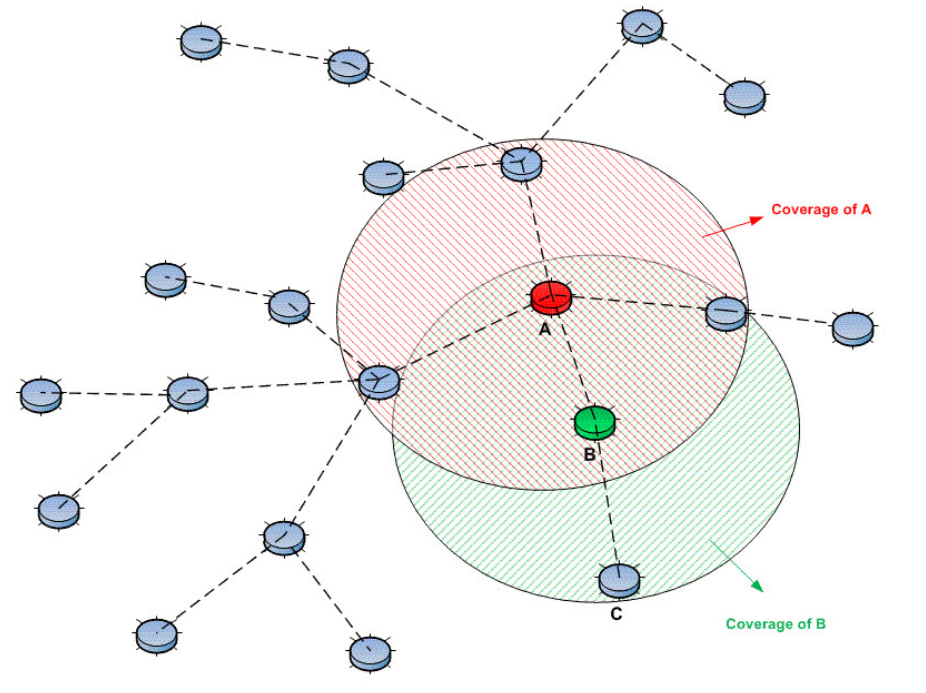
Figure 11. An example of a clustered network with a maximum hop distance of